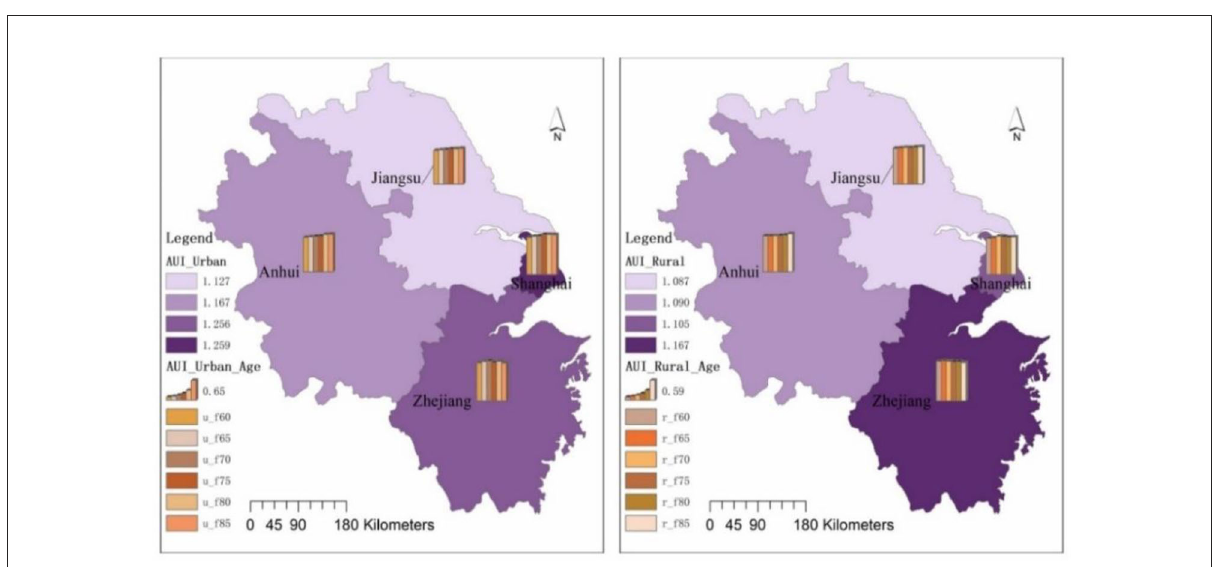
FIGURE7 Aids use index for the elderly in urban and rural areas in Jiangsu, Shanghai, Zhejiang and